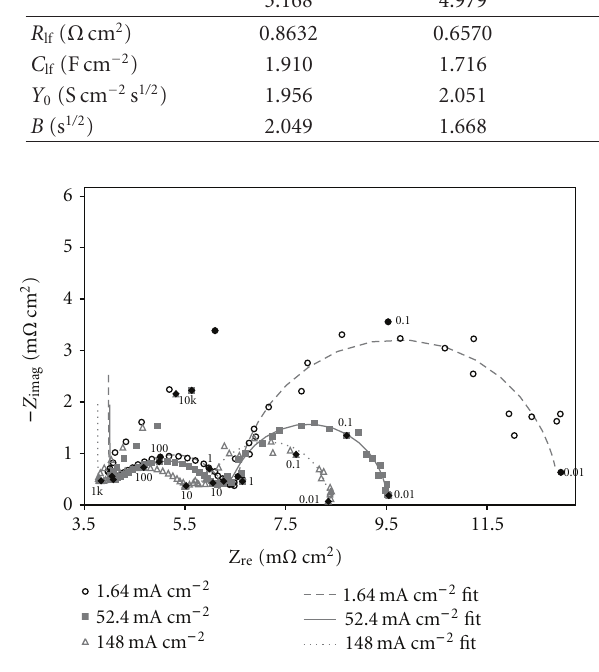
Figure 9: Nyquist plot of a planar fuel cell stack fed with 97% H 2 and balance H 2 O operating at 800 ◦ C and varying load current. The data have been fitted to a four-RC equivalent